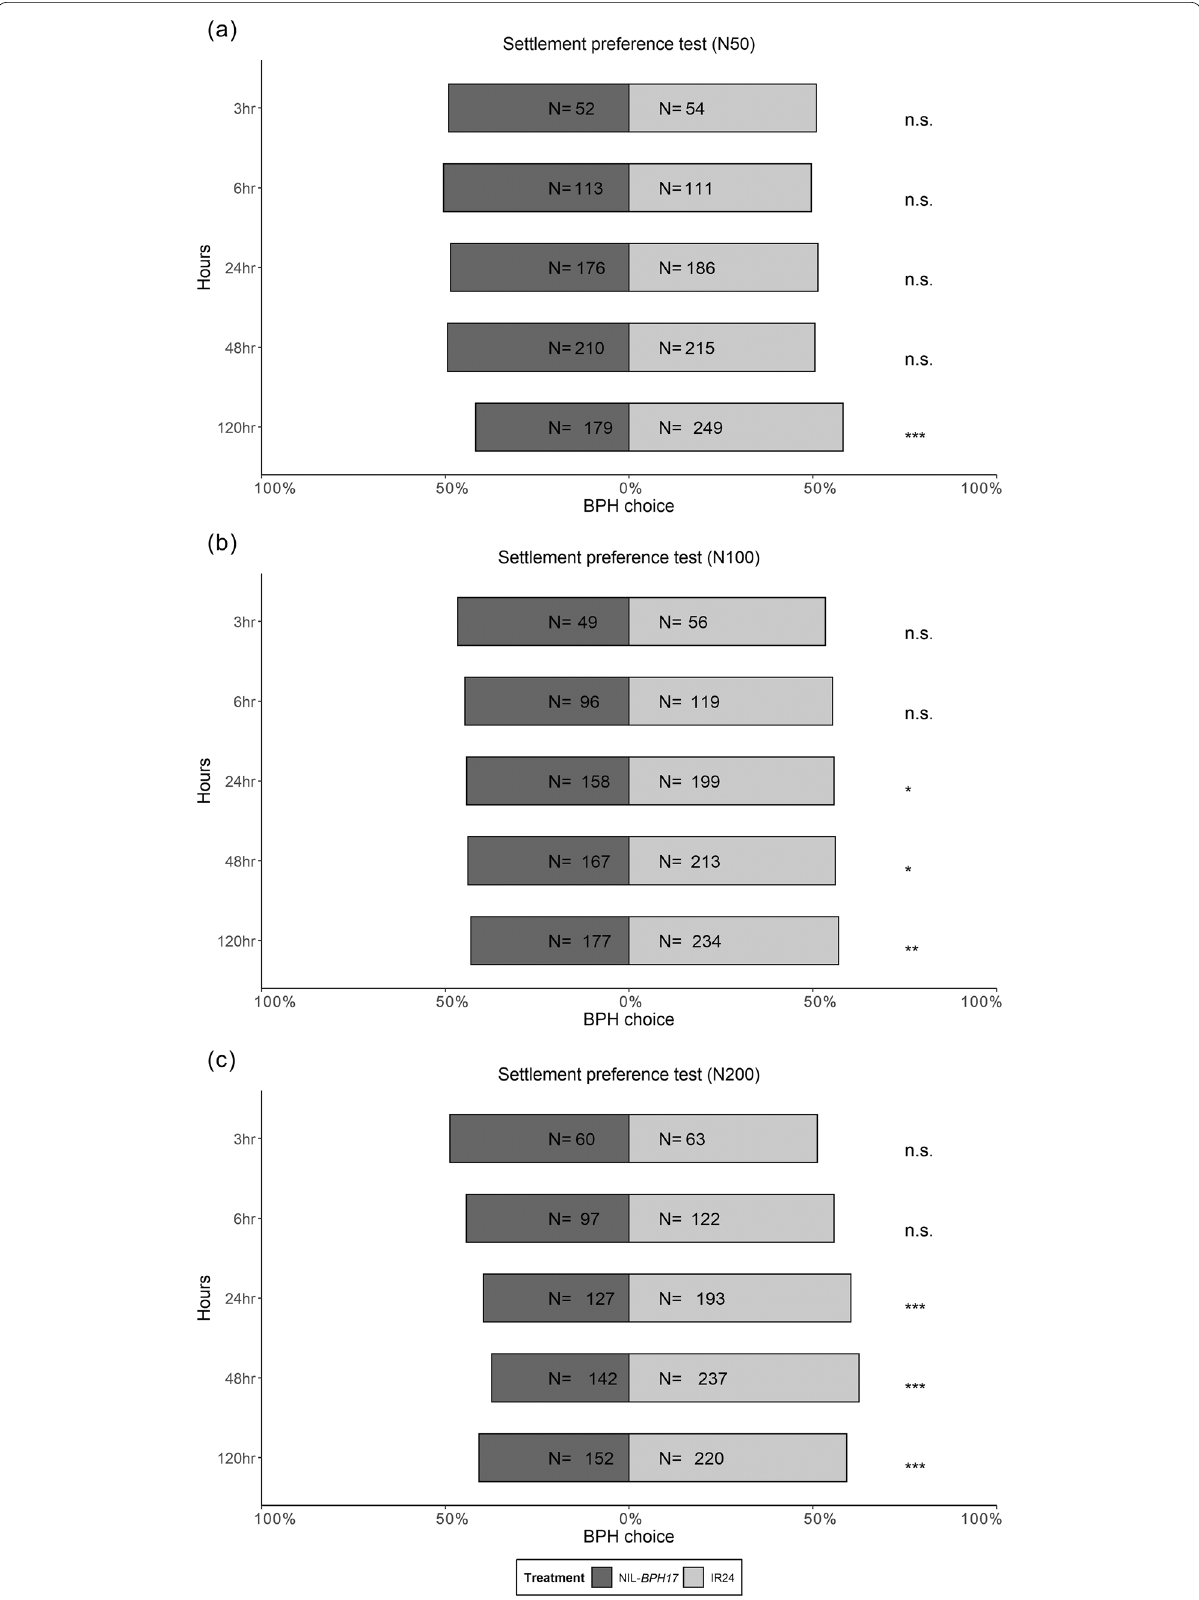
Fig. 7 (See legend on previous